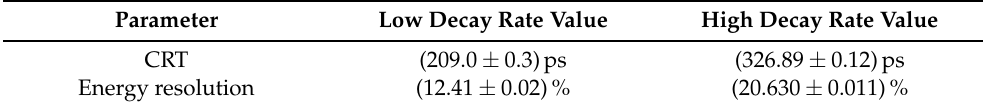
Table 5. CRT and energy resolution at low and high decay rate with the point and line source, respectively.